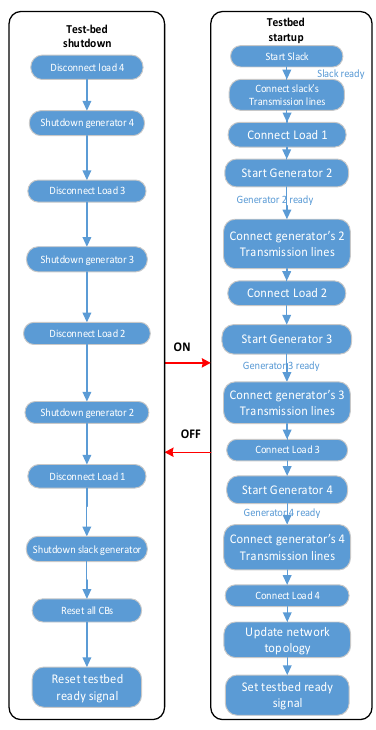
Figure 15. Main automation and startup controller.